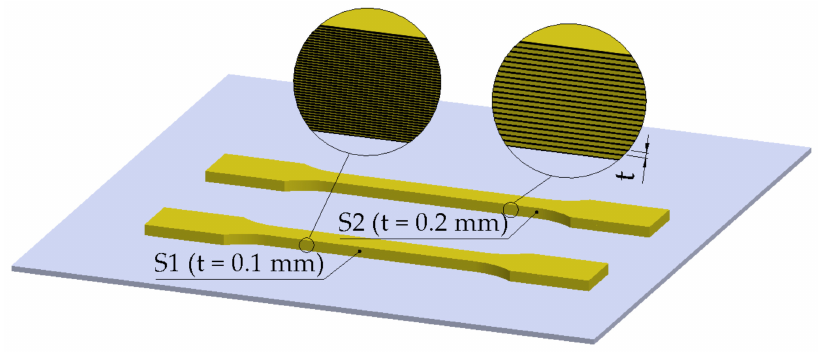
Figure 1. Layer thickness (t) for ISO 527-2 Type 1A tensile test specimens (S1,